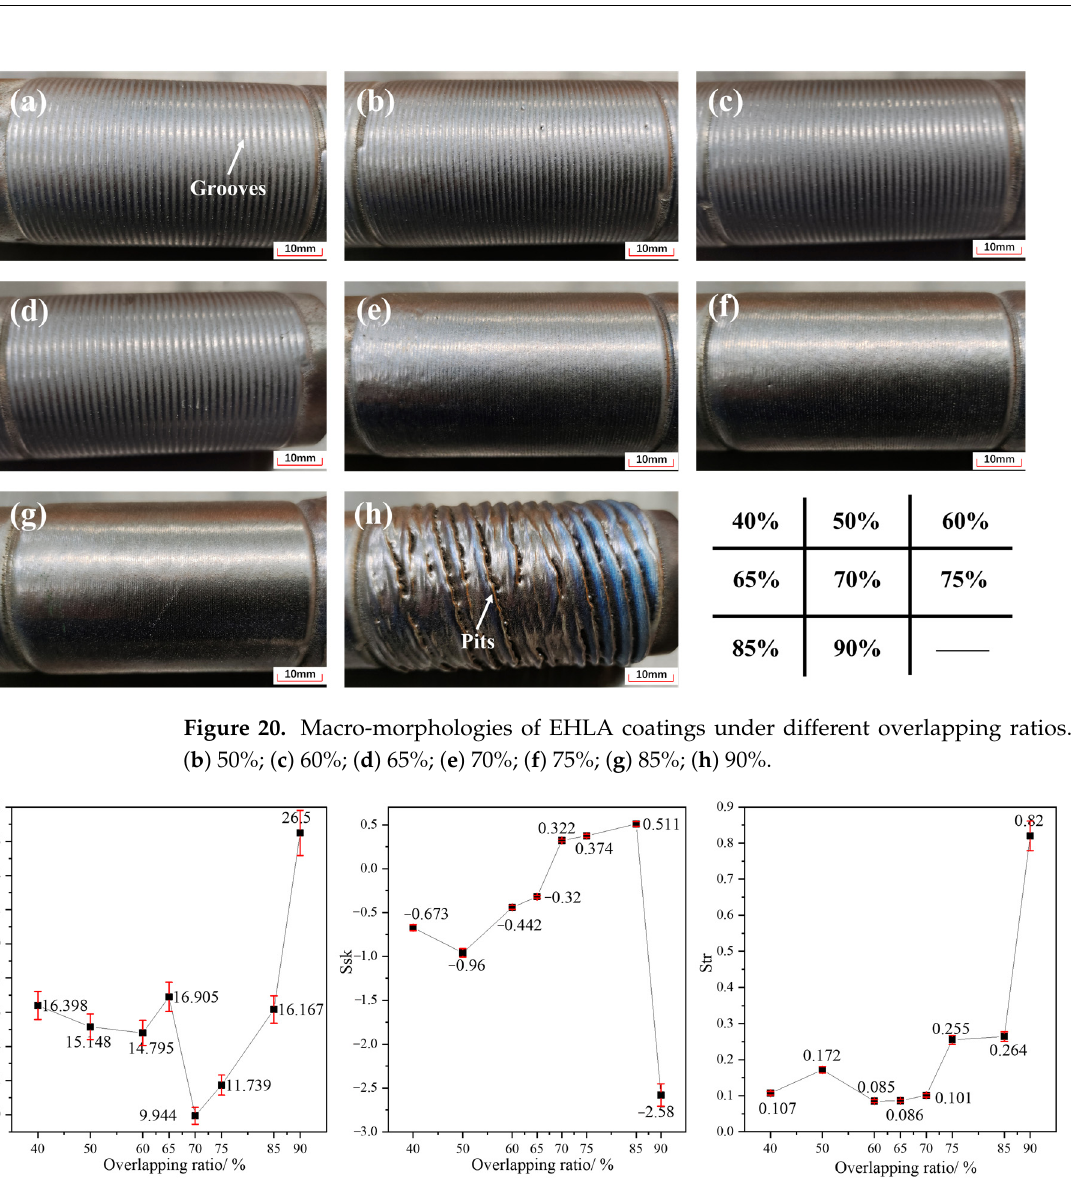
Figure 21. Variations of S a , S sk , and S tr with di ff erent overlapping ratios.